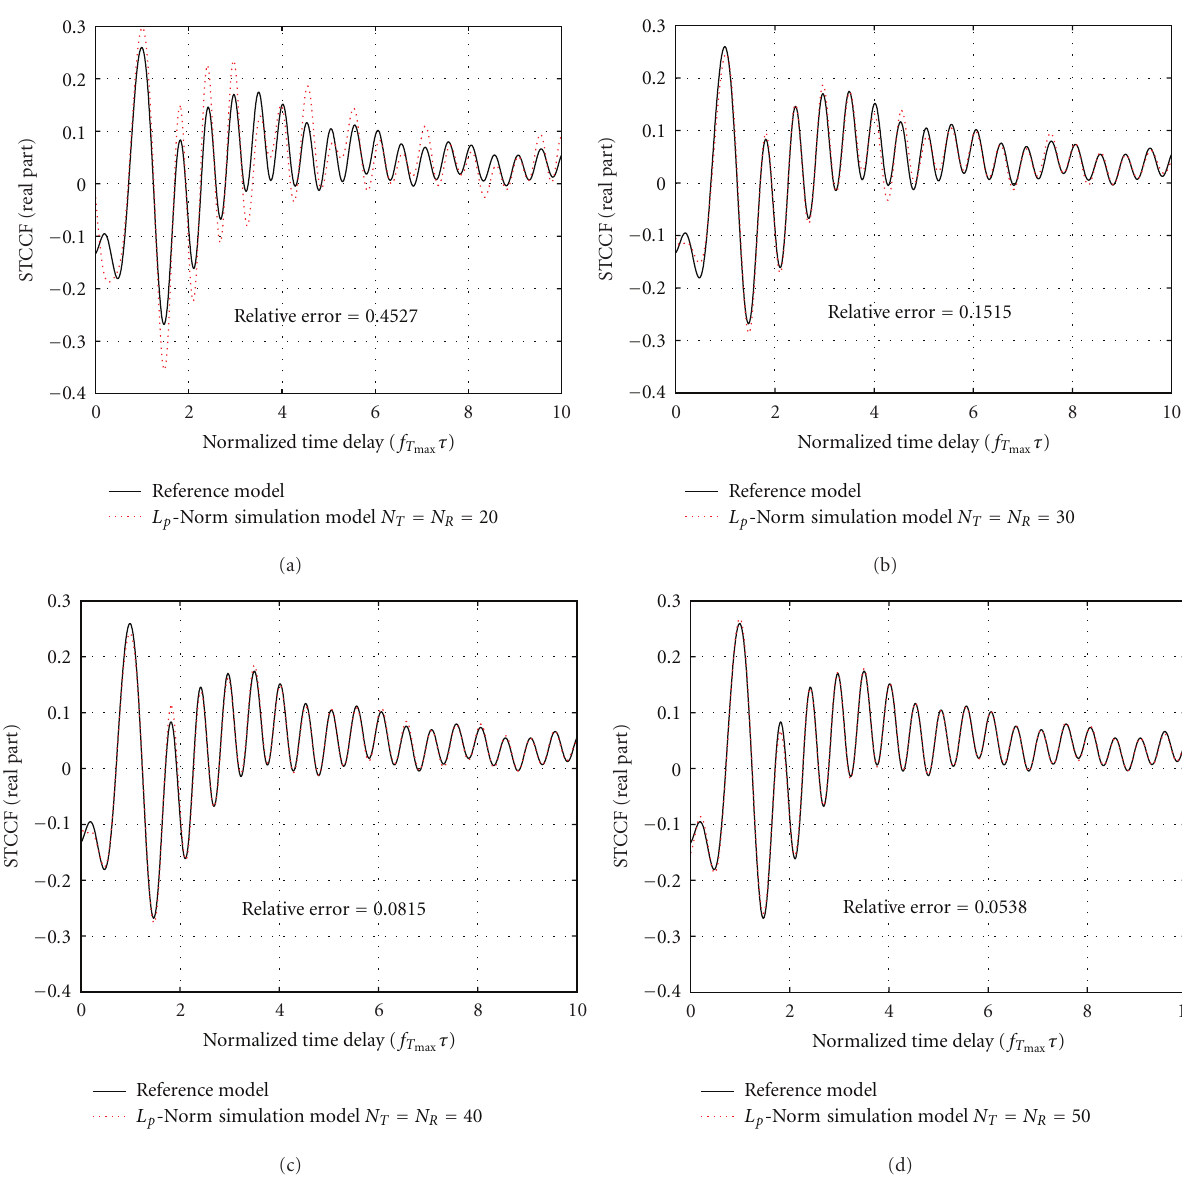
pq δ lm λ and N N T = R = 20, 30, R = 1 T =